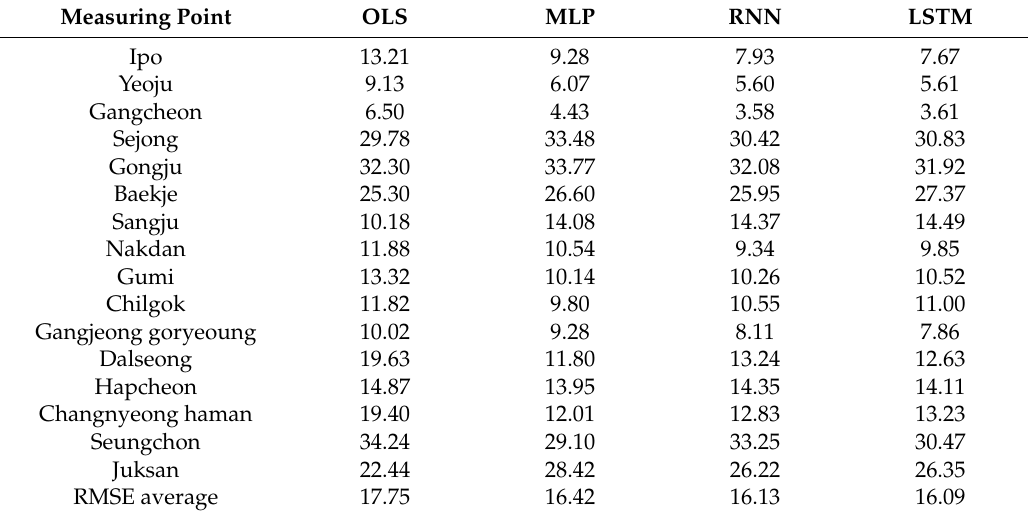
Table 4. Results of RMSE